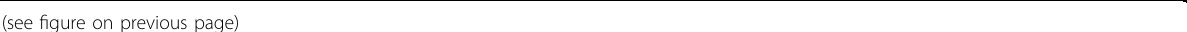
Fig. 1 Expression and colocalization of MOR and CCKBR on the membrane of cells. ( a ) Colocalization of MOR (green) and CCKBR (red) examined with double immuno fl uorescent staining in the spinal dorsal horn (top panel) and in the DRG (bottom panel). Scale bar = 10 μ m. b Co- expression of HA-MOR and FLAG-CCKBR in co-transfected HEK293 cells revealed by western blots using anti-HA or anti-FLAG antibody. Compared with wild-type HEK293 cells, MOR and CCKBR protein expression could be detected. c Distribution of HA-MOR and FLAG-CCKBR in co-transfected HEK293 cells examined with immuno fl uorescent labeling with anti-HA or anti-FLAG antibody. Scale bar = 25 μ m. d Expressions of MOR-EGFP and CCKBR-mCherry in co-transfected HEK293 cells examined with western blot. e Colocalization of MOR-EGFP and CCKBR-mCherry in co-transfected HEK293 cells shown by confocal microscopy imaging. Scale bar = 25 μ